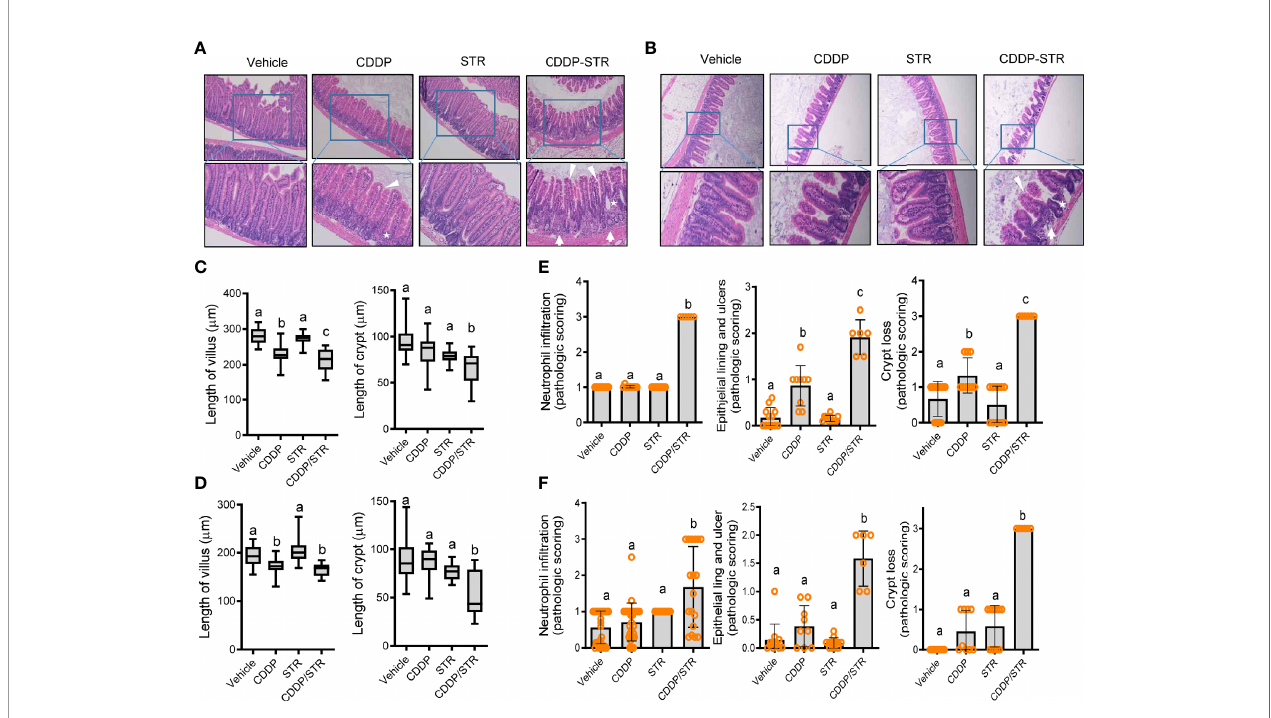
FIGURE 3 | Histopathological effects of STR exposure on jejunum and ileum in CDDP-induced renal injury model. Eight-week-old wild type male mice (n = 3 – 5) were orally preexposed to the vehicle or streptomycin (20 mg/mouse) for 24 h and then renal injury was induced with CDDP (20 mg/kg) via intraperitoneal administration for an additional 72 h. (A, B) Histological observation of hematoxylin and eosin (H&E)-stained sections of the small intestine [jejunum (A) and ileum (B) ] [magni fi cation 100× (upper) and 200× (lower) with scale bar(s): 100 m m]. The arrows indicate neutrophil in fi ltration, stars indicate crypts, and arrowheads indicate epithelial lining integrity. (C, D) Quantitative comparisons of villus length (left) and crypt length (right). The results are shown as a box plot with Tukey whiskers and the different letters (a – c) over each box represent signi fi cant differences between groups (p<0.05) in the jejunum (C) and the ileum (D) . (E, F) Quantitative pathological scoring of neutrophilic in fi ltration (left), epithelial lining and ulcers (middle), and crypt loss (right) in the jejunum (E) and the ileum (F) . Results are representative of three independent experiments. The results are shown as a bar graph and the different letters over each bar represent signi fi cant differences between the groups using ANOVA with Newman – Keuls method as a post hoc ANOVA assessment